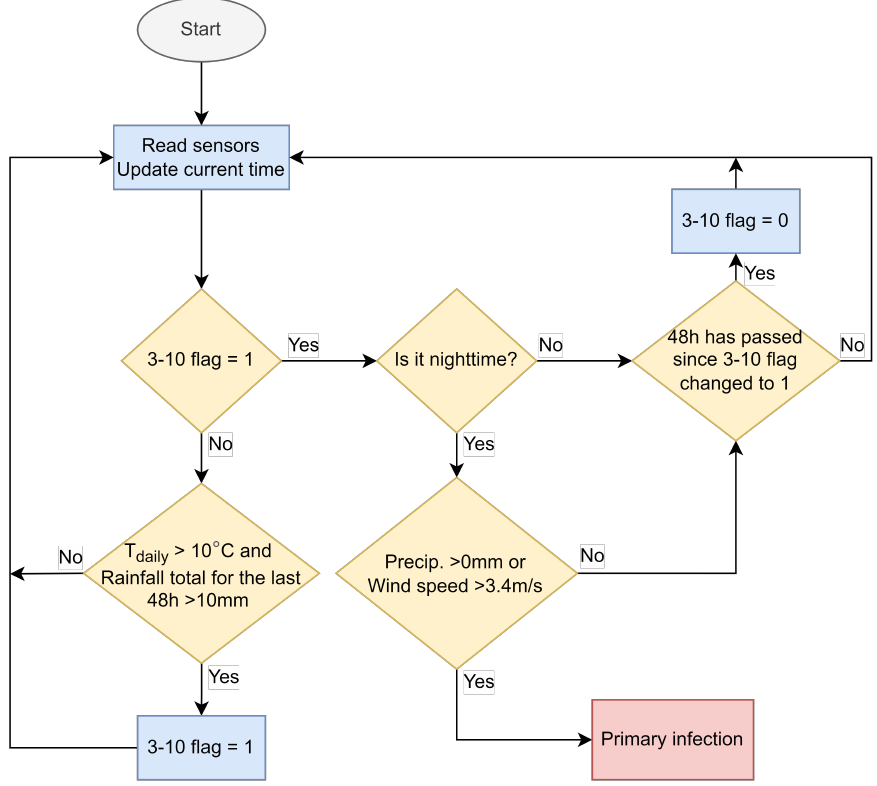
Figure 3. Algorithm for primary infection